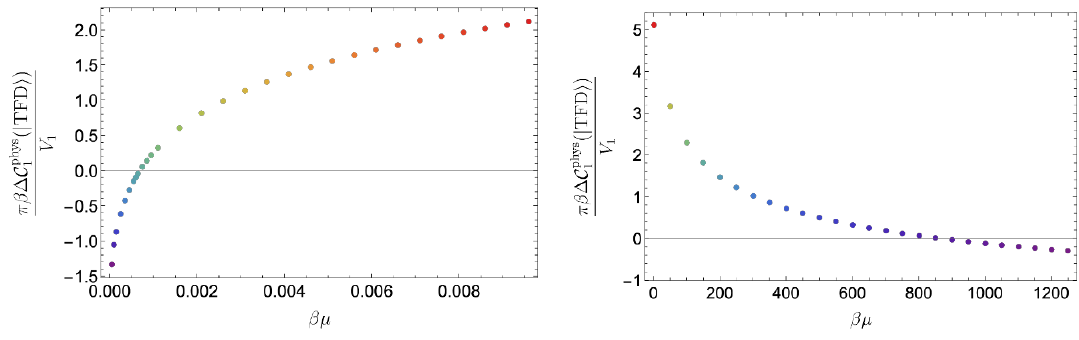
Figure 14 . The integrated mutual complexity in the physical basis (cid:1) C phys for a massless free scalar (cid:12)eld theory in d = 2 as a function of (cid:12)(cid:22) . The two plots show di(cid:11)erent regimes of the parameter (cid:12)(cid:22) . The integrated mutual complexity is negative when (cid:12)(cid:22) is very small or very